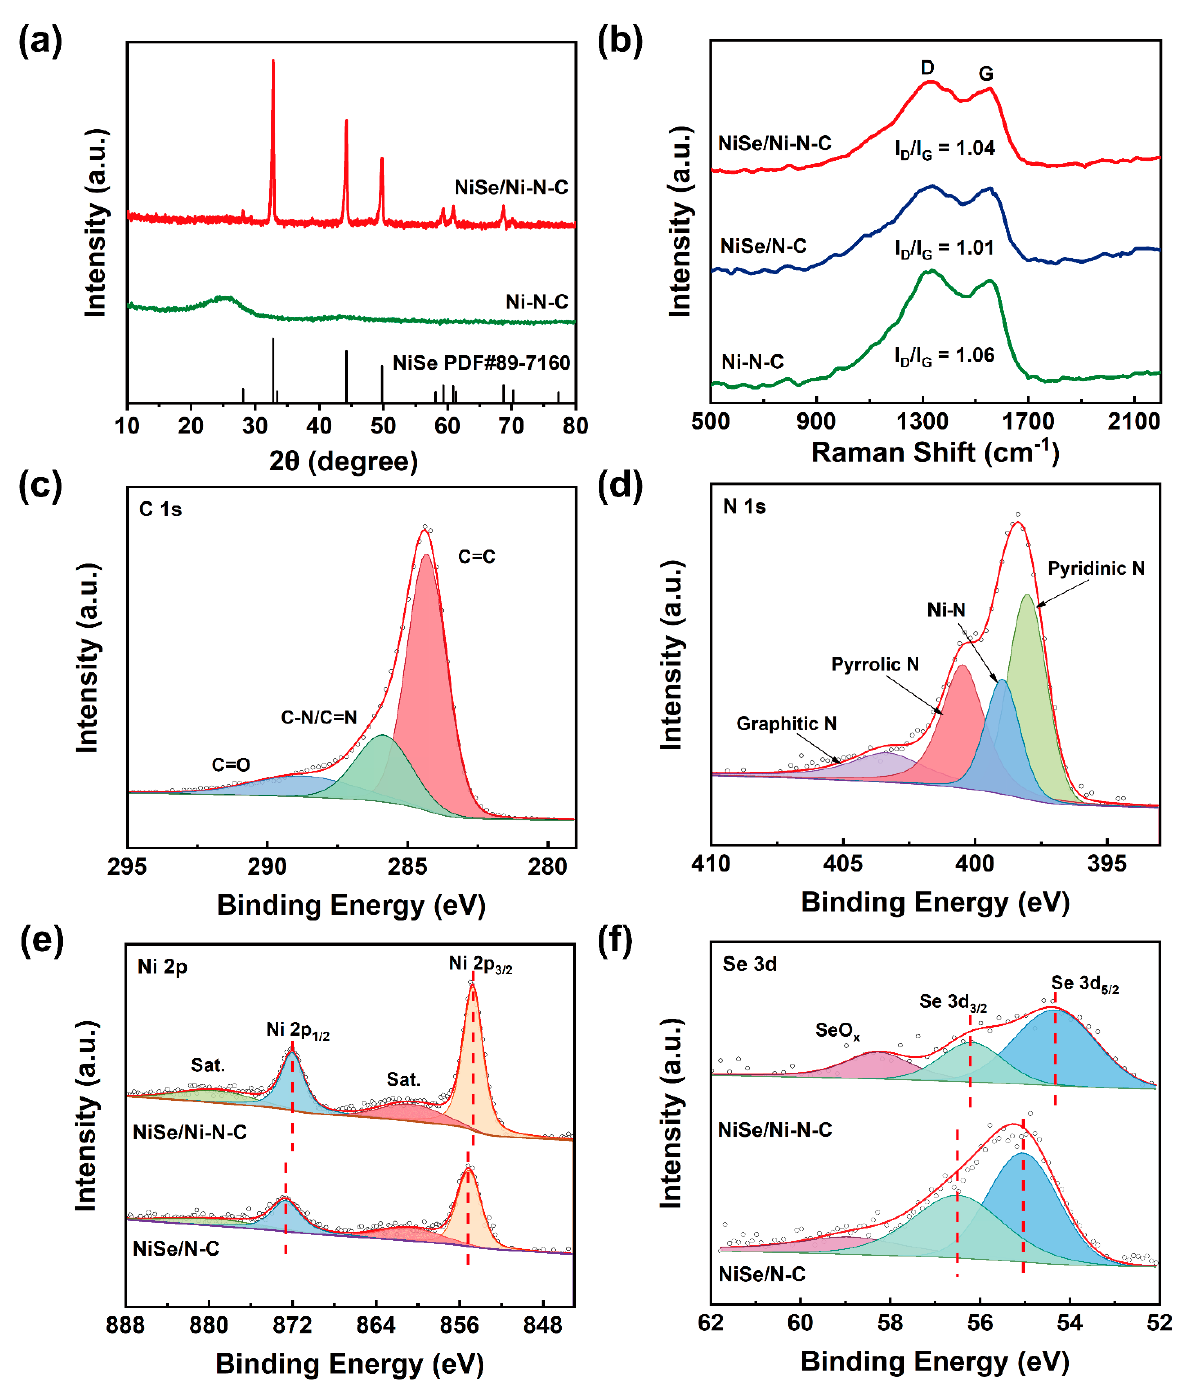
Figure 2. ( a ) XRD patterns; ( b ) Raman spectra; XPS profiles and deconvolutions of ( c ) C 1s, ( d ) N 1s, ( e ) Ni 2p, ( f ) Se 3d of NiSe/Ni–N–C and